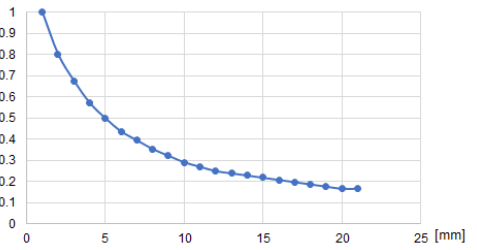
Figure 7. Characteristics of infrared distance sensor. The horizontal axis shows the distance between the sensor and the skin, and the vertical axis shows the normalized sensor output